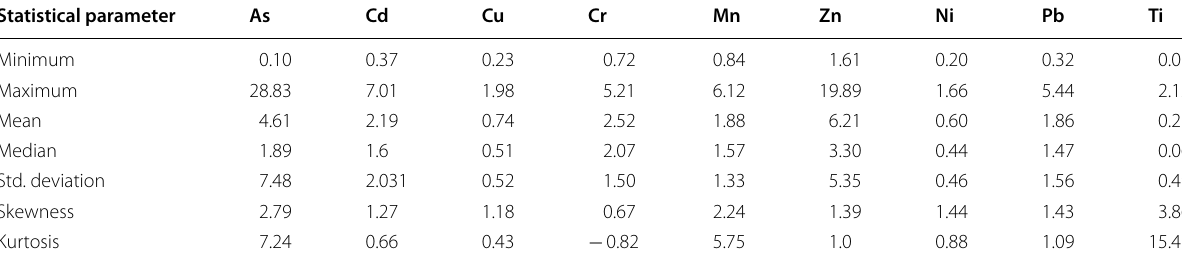
Table 9 Statistical parameters of the enrichment factor Statistical